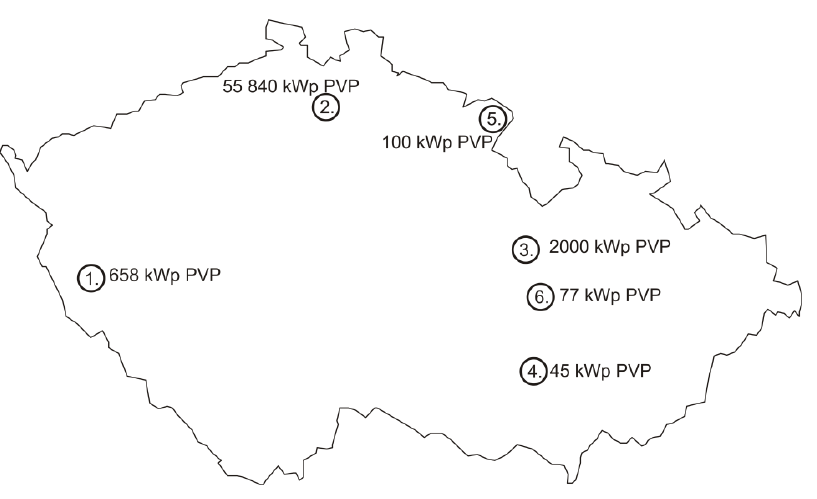
Figure 7. Locations of the inspected PV